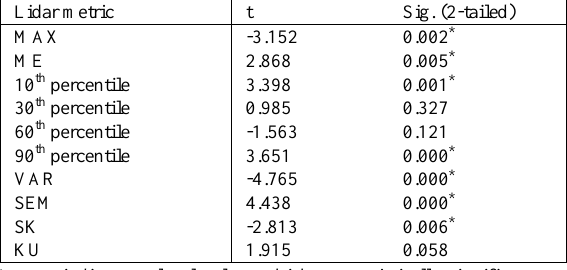
Table 1. Paired-samples t-test results for comparison of textural- based and spectral-based